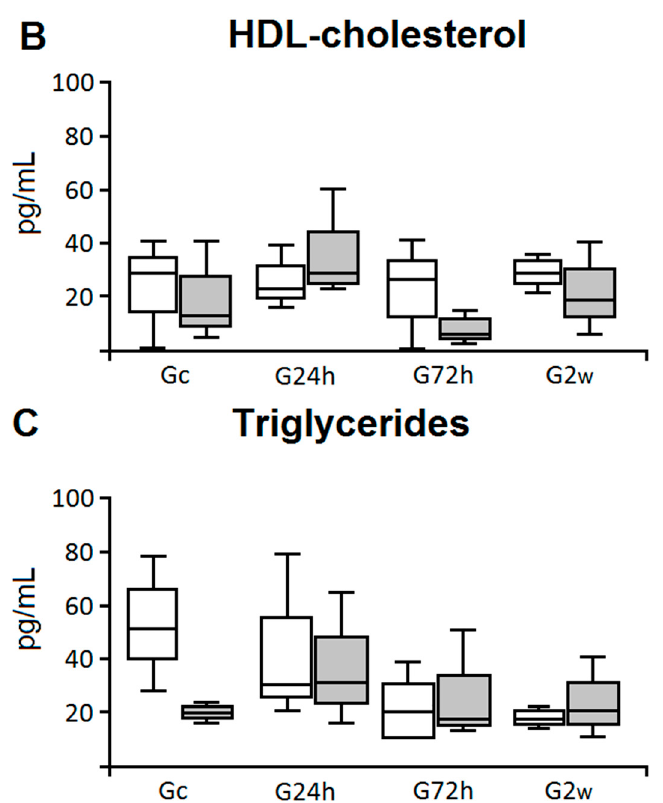
Figure 1. Lipid profile of normotensive and hypertensive rats after daily supplementation with omega-3 ( ω -3). The levels of total cholesterol ( A ), cholesterol-HDL ( B ) and triglycerides ( C ) were quantified after 24 h, 72 h and 2 weeks of ω -3 supplementation and after 2 weeks of water intake in normotensive (WKY) and hypertensive (SHR) animals. The p values for comparisons between models at a specific time are shown in the panel. * p = 0.001, G72h SHR vs. G72h WKY. HDL, High-Density Lipoprotein; Gc, Control group; G24h, 24 h group; G72h, 72 h group; G2w, 2 weeks group